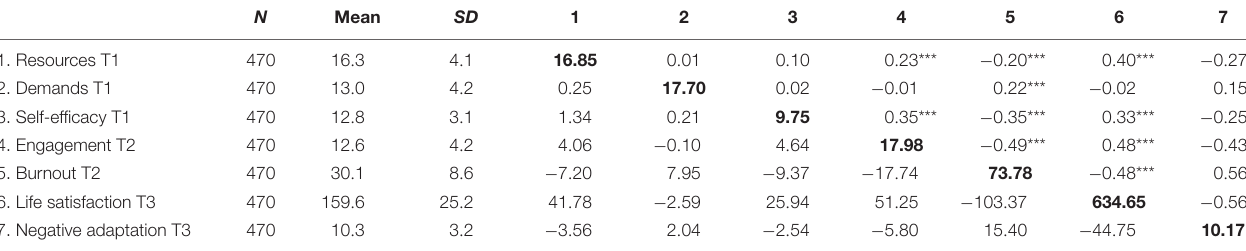
TABLE 2 | Variance-covariance-correlation matrix ( N = 470).